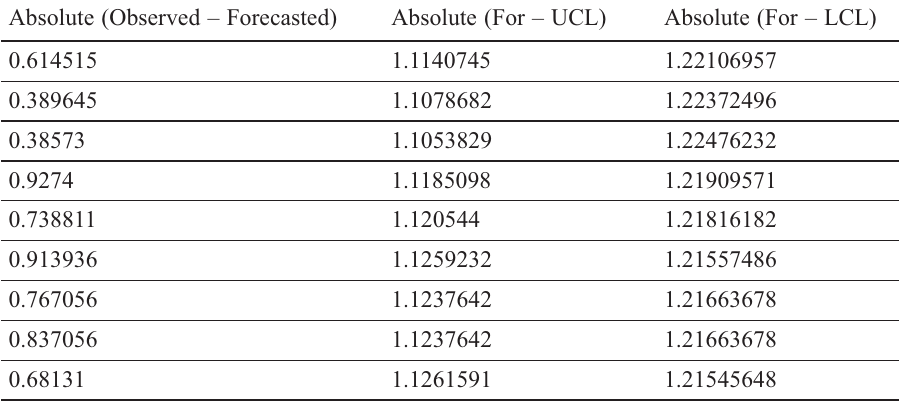
Table 2. The absolute value of the differences (Observed – Forecasted), (Forecasted – UCL), (Forecasted – LCL) for all the Forecasted prices Absolute (Observed –